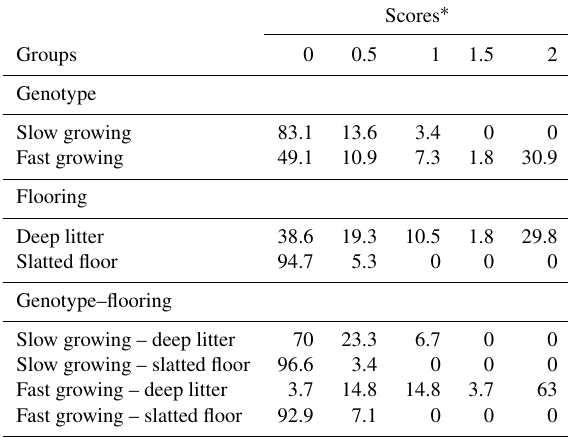
Table 2. Prevalence of hock-joint dermatitis in the groups in week 8